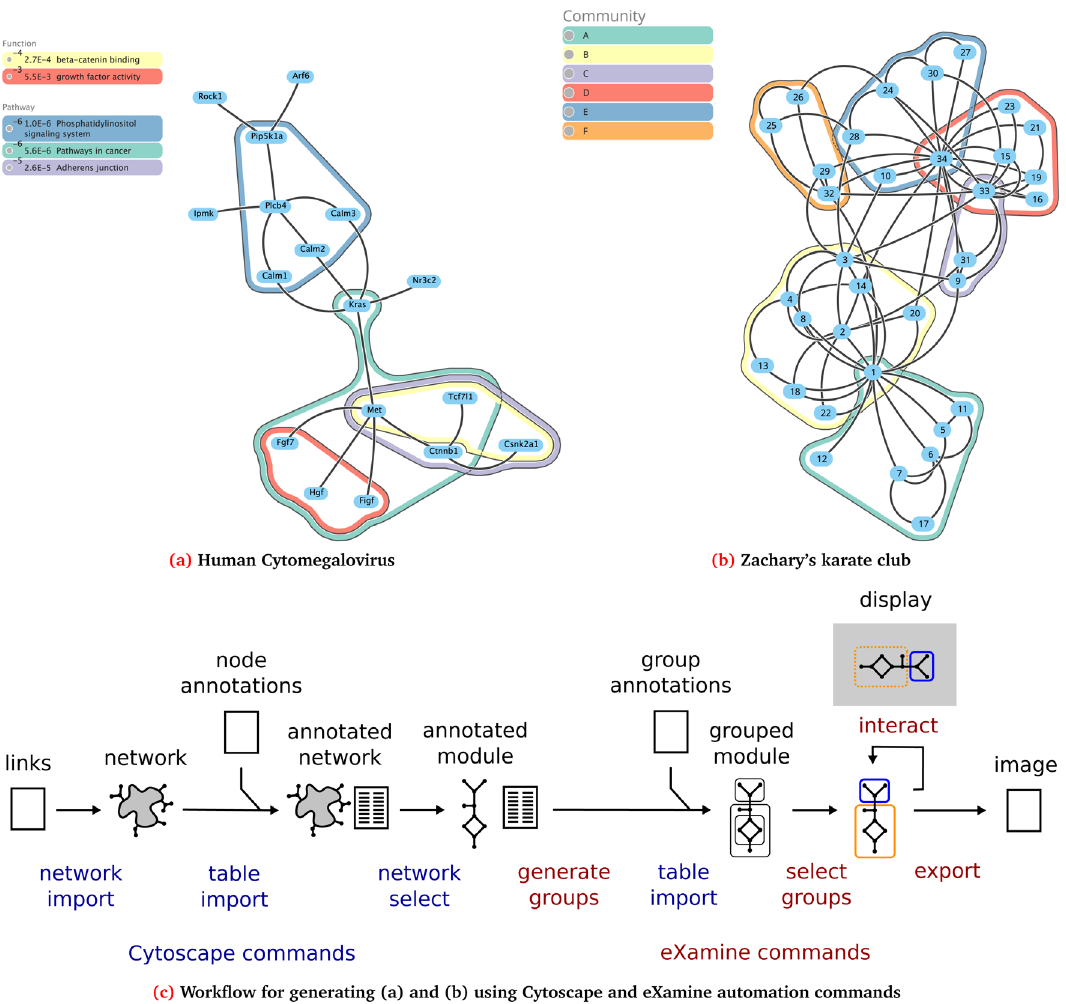
Figure 1. eXamine displays set membership as contours on top of a node-link layout. ( a – b ) The graphs generated in the two use cases using eXamine’s automation features. ( c ) The first step in the workflow consists of importing